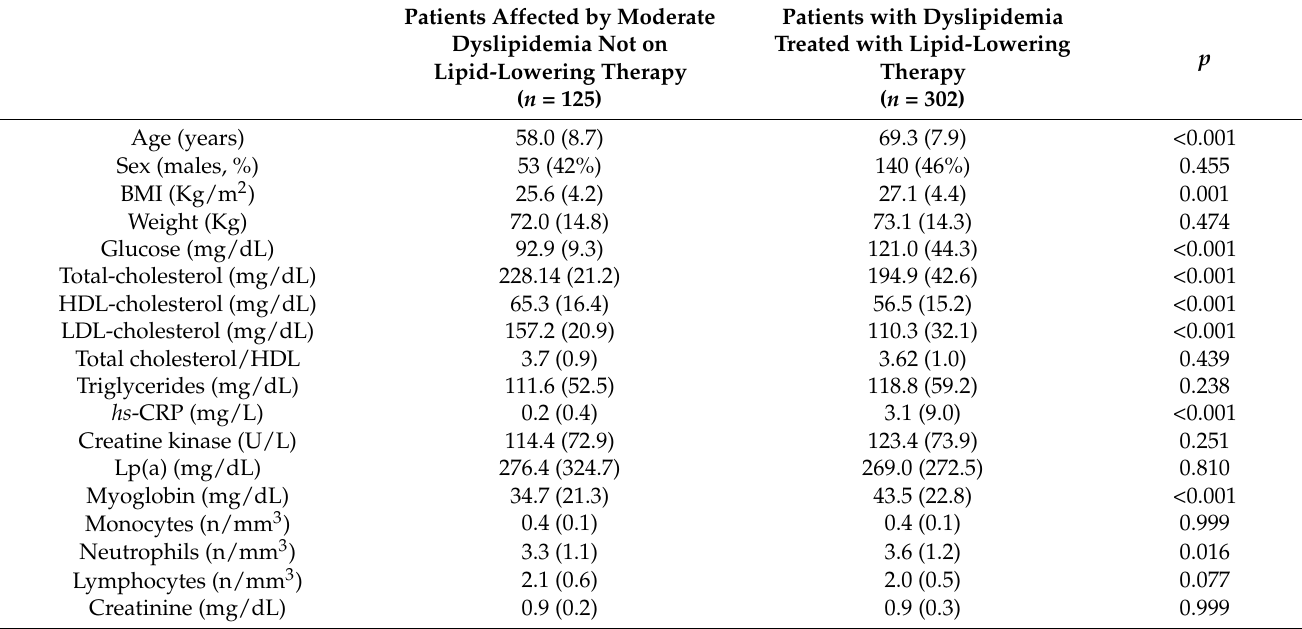
Table 1. Clinical and metabolic variables of the enrolled subjects.